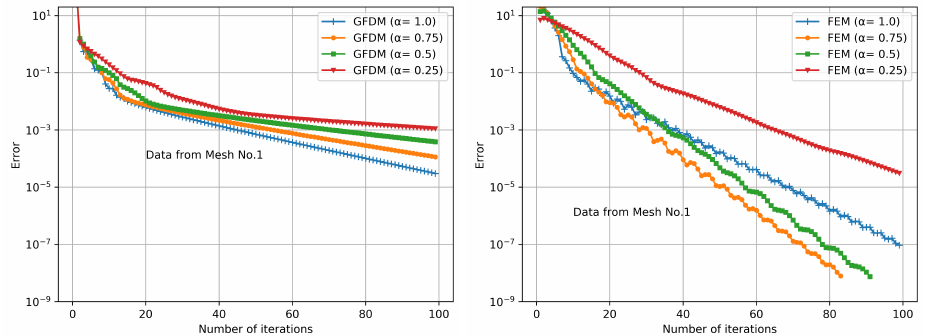
Figure 9. Convergence history on mesh no. 1 (coarse